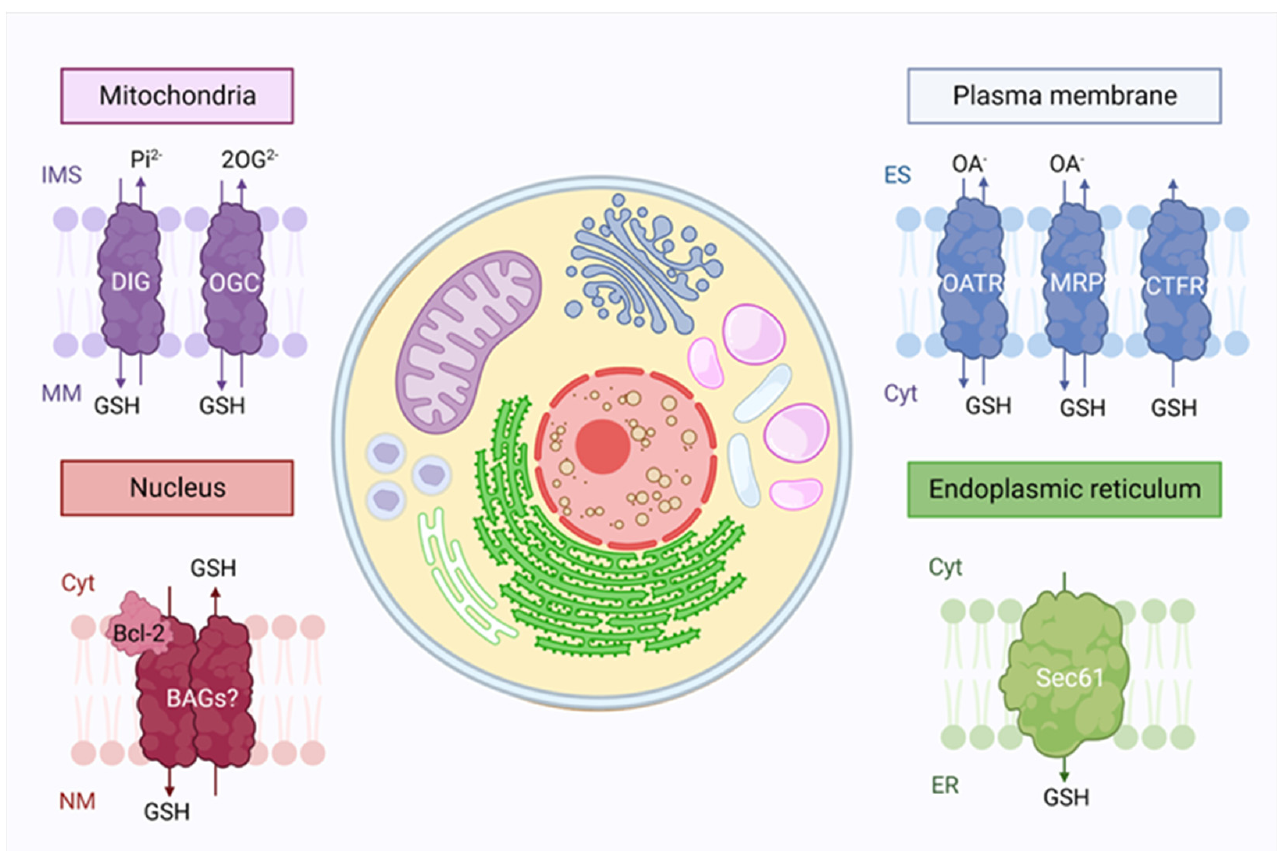
Figure 2. Glutathione intracellular compartmentalization. Glutathione synthesis takes place only in the cytosol (cyt), but it is distributed to many organelles due to the presence of transporters. In mitochondria, the outer membrane contains a large amount of porins, which allow glutathione transport, while dicarboxylate (DIG) and the oxoglutarate (OGC) transporters are present in the inner membrane. In the nucleus, Bcl-2 proteins are believed to be involved in the GSH translocation through Bcl2-associated athanogene pores (BAG). Glutathione is also found in the endoplasmic reticulum (ER), where its facilitated diffusion occurs through the Sec61 protein-conducting channel. Finally, the exchange between extracellular and intracellular glutathione in the plasma membrane occurs through the functioning of three families of transporters: the organic-anion-transporting polypeptide (OATR), the drug resistance-associated proteins (MRP) and cystic fibrosis transmembrane conductance regulator (CTRF). IMS: Intermembrane space, MM: Mitochondrial matrix, NM: Nuclear matrix, ES: Extracellular space.